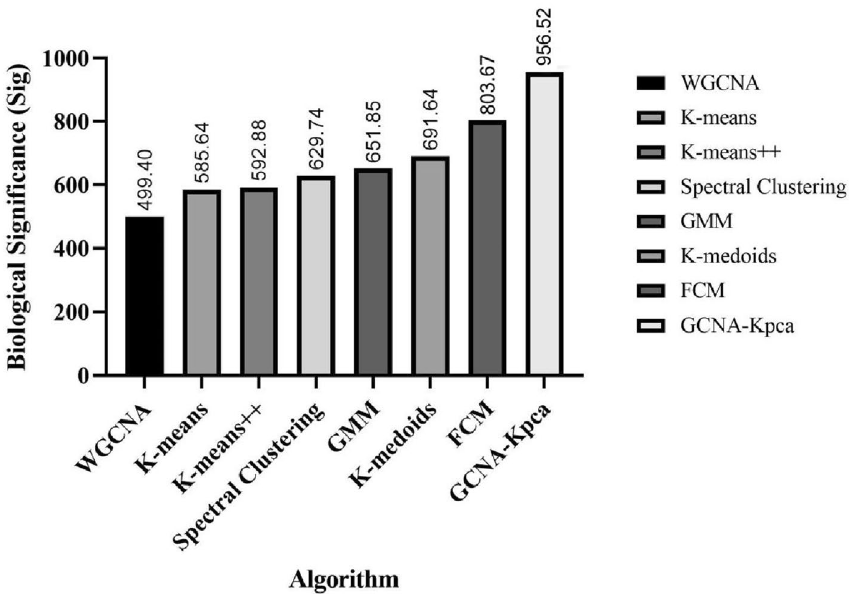
Figure 3. The biological significance of gene modules identified by K-means, K-means++, K-medoids, GMM, Spectral Clustering, FCM, WGCNA and GCNA-Kpca. This figure was drawn with GraphPad Prism 9.